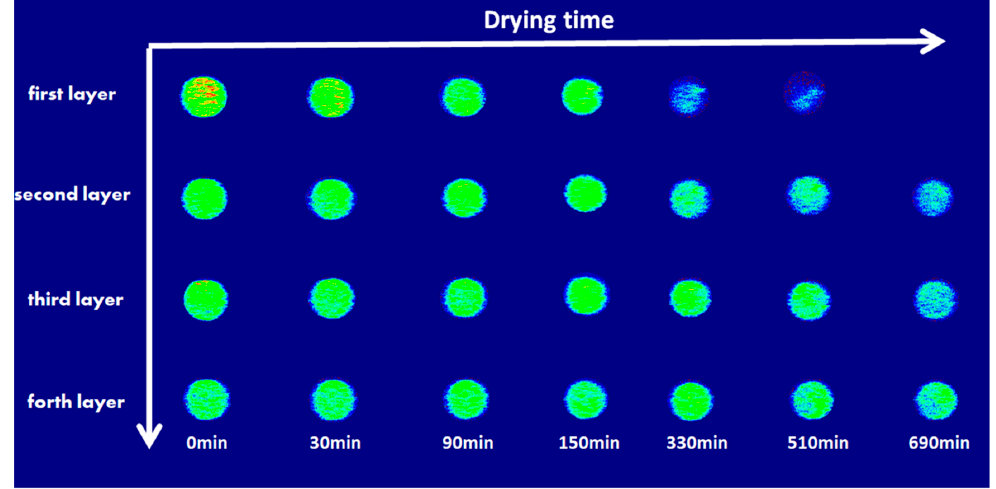
Figure 8. The layered water content curve of the sample at different drying times. ( a ) The NaCl solution; ( b ) the Na 2 SO 4 solution.